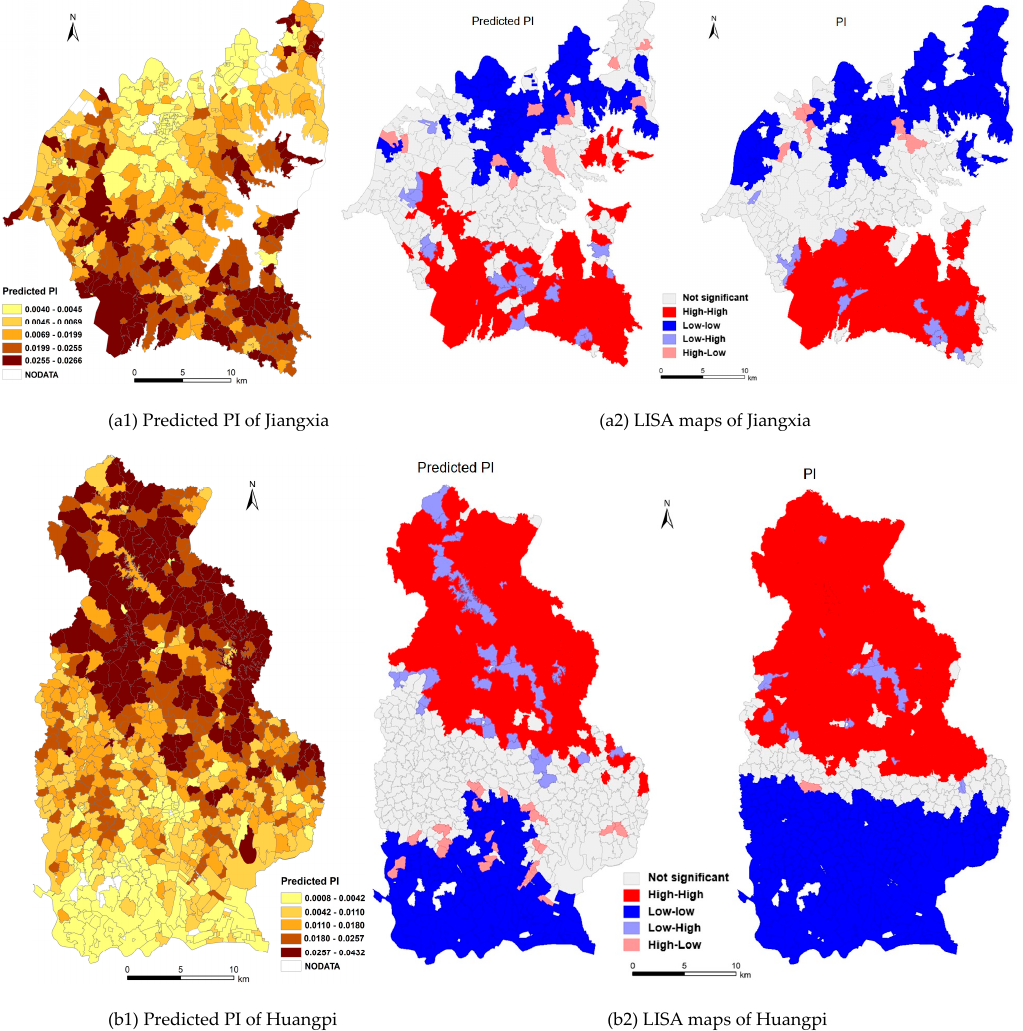
Figure 4. Predicted PI ( a1 , b1 ) and LISA ( a2 , b2 ) maps of predicted PI with remote sensing-derived variables vs. survey-based PI of Jiangxia and Huangpi.